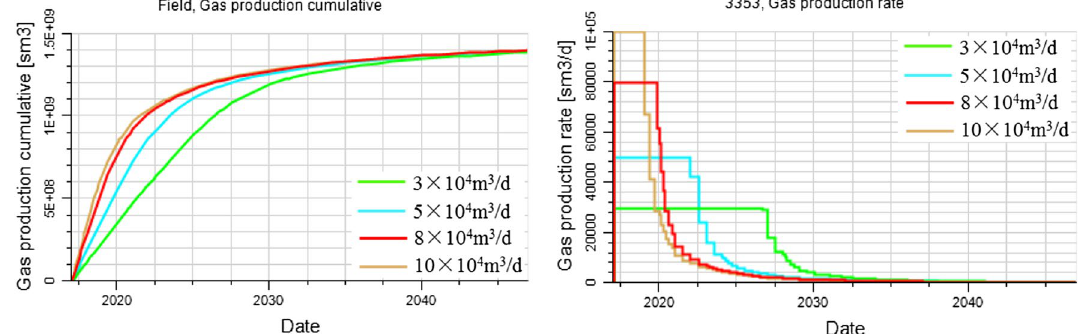
Fig. 11 Demonstration of gas production rate—the cumulative gas production curve and daily gas production curve of single well of the sweet